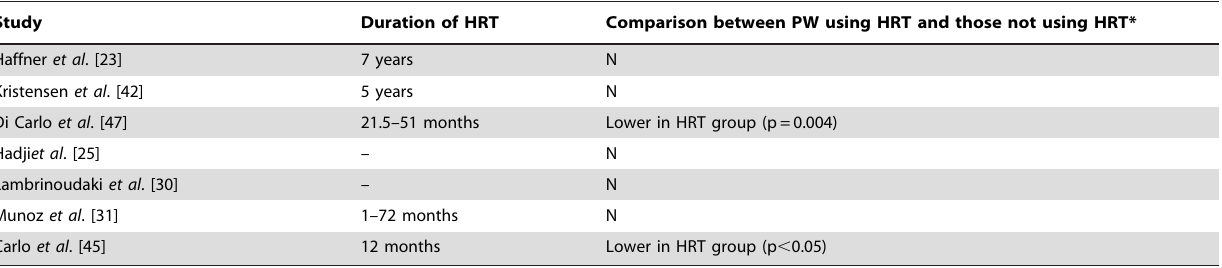
Table 3. LC in healthy PW and HRT users in the included studies.